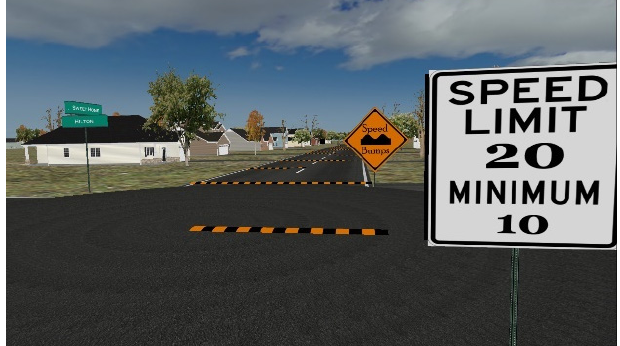
Figure 9. Speed modulation (challenge).